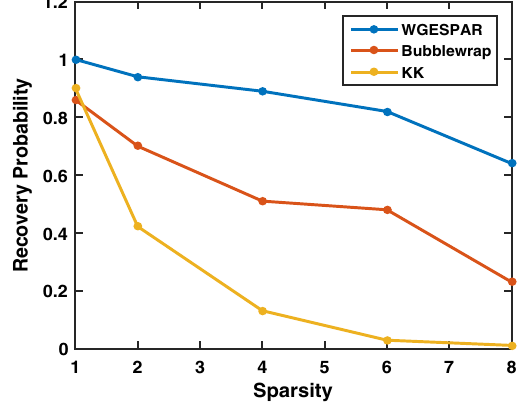
FIG. 3. Recovery probability of the KK method, the Bubble- wrap algorithm, and the WGESPAR algorithm.